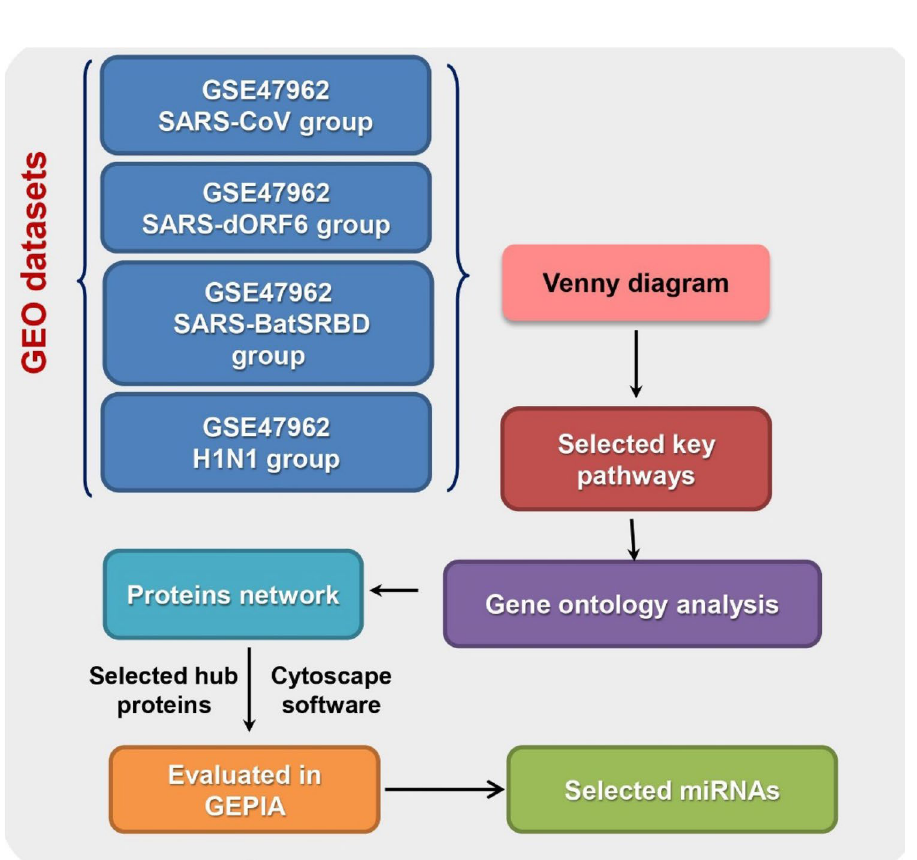
Figure10. An overview of all the analyses performed in the current